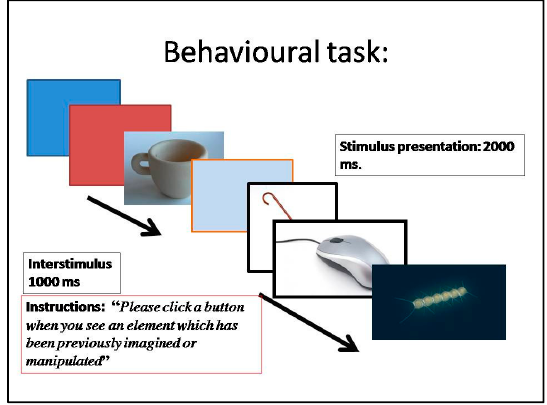
Figure 4. Behavioral task: go-no go task.